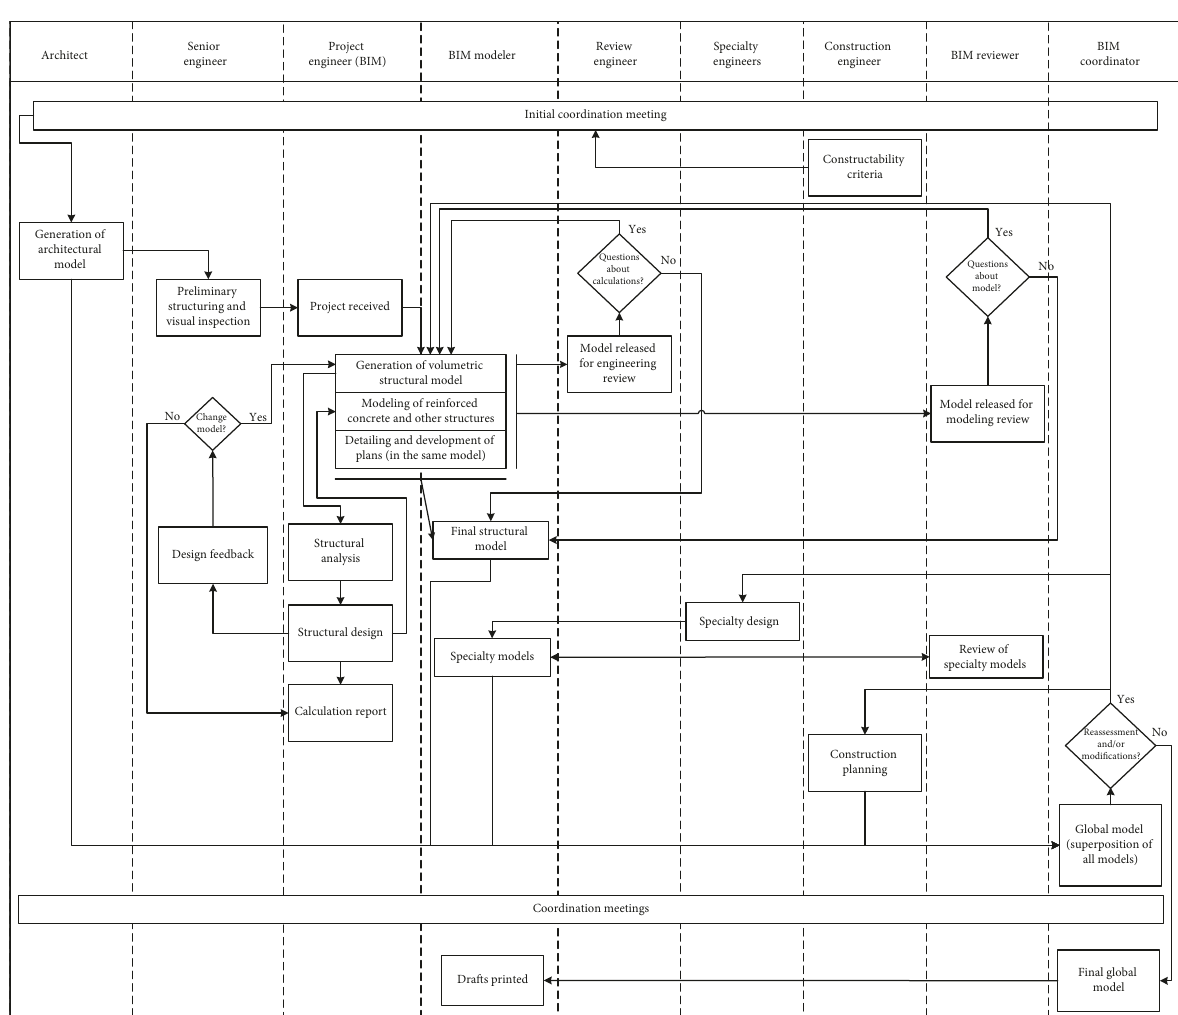
Figure 5: Workflow under the BIM